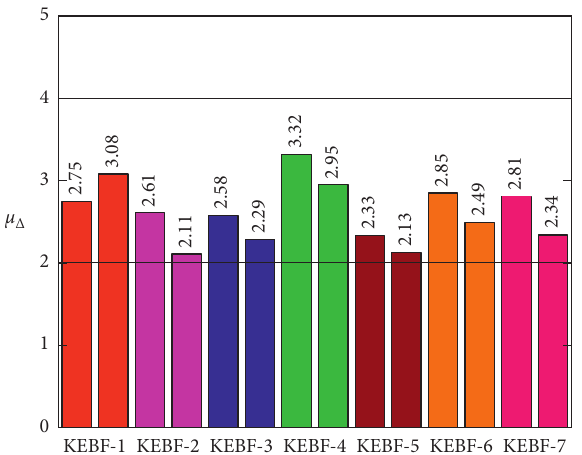
Figure 36: Ductility coefficient of each